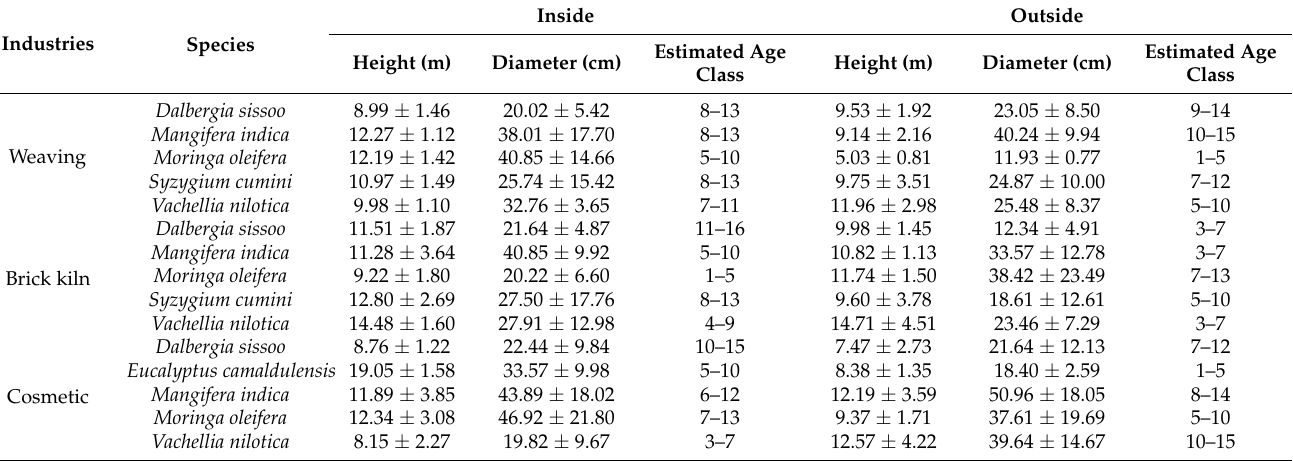
Table 3. Height (m) and diameter (cm) of different tree species present inside and outside the different industries. Values were reported as mean ± standard